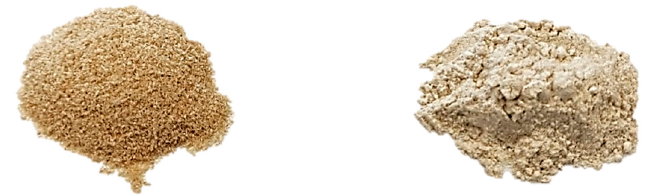
Figure 1. Thin bran ( left ) and barley flour ( right ).